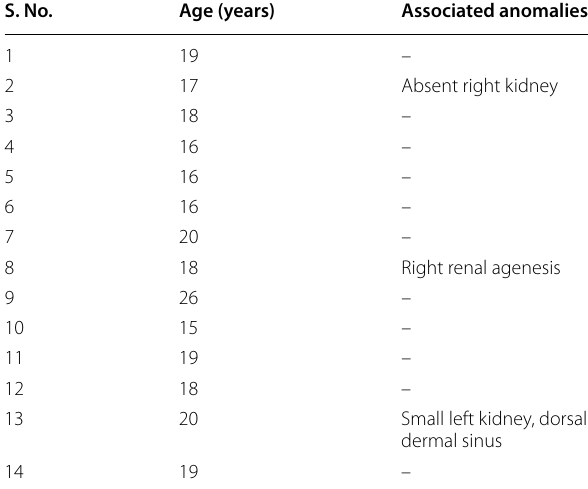
Table 4 tabulates the associated anomalies of urinary tract or spine in 14 subjects S.